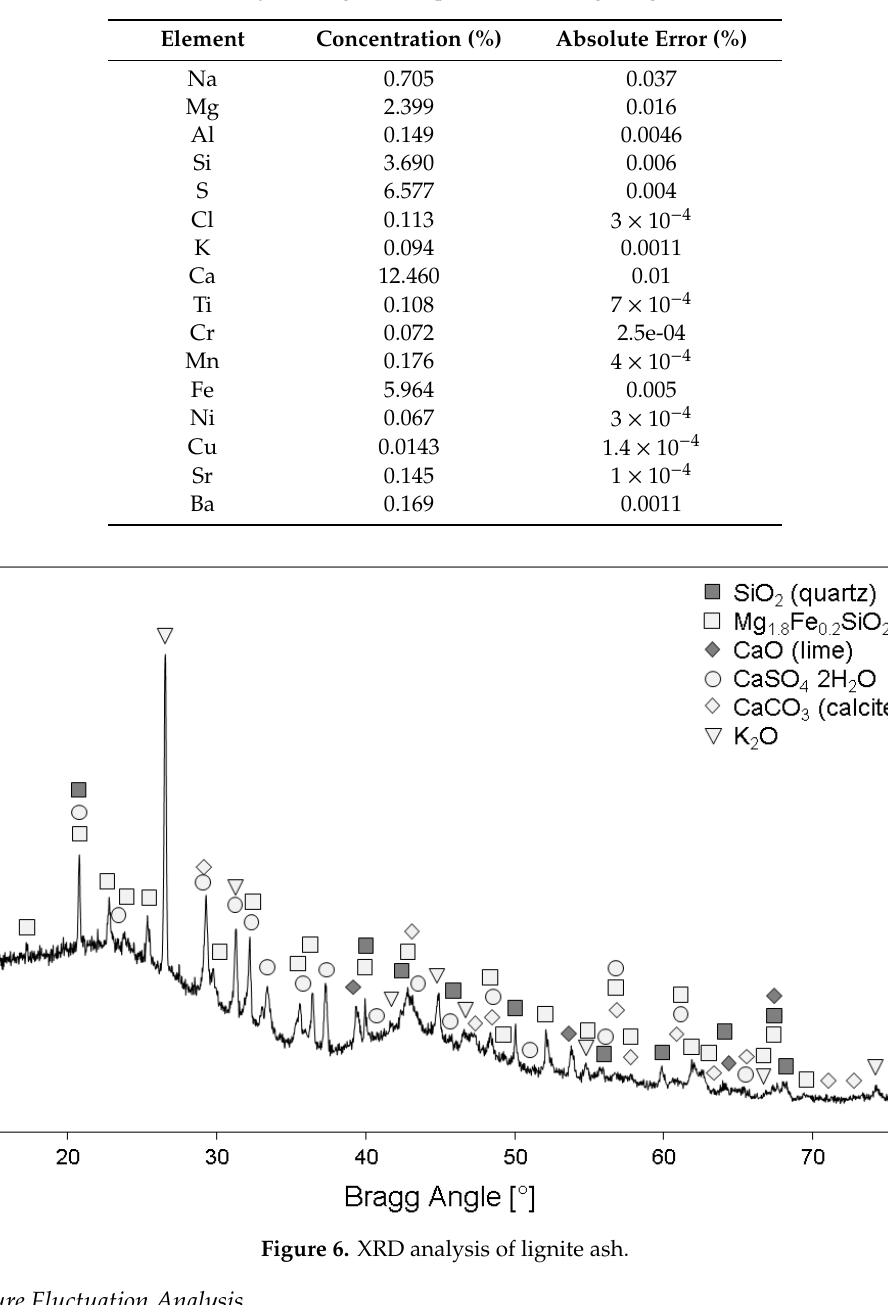
Table 4. XRF analysis of lignite ash produced during the gasification test . Element